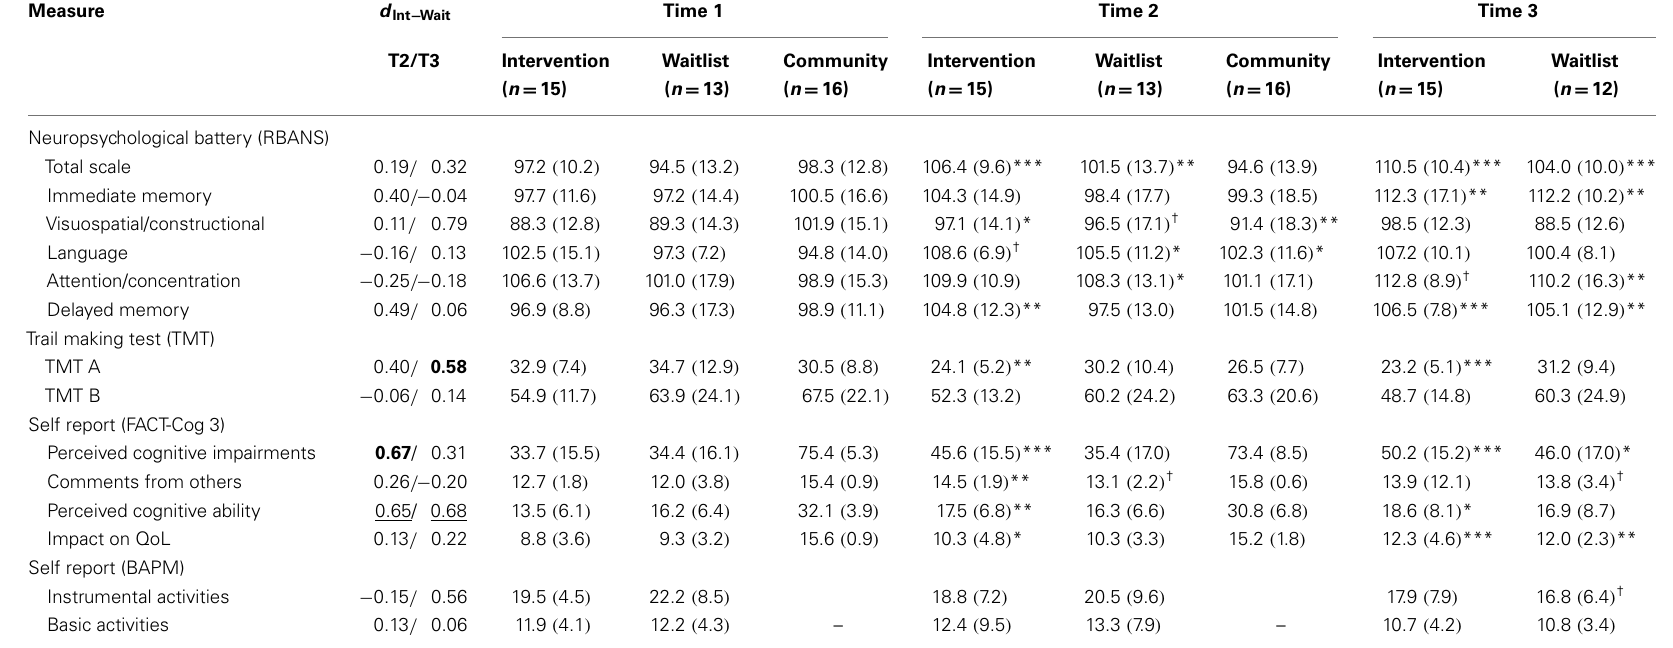
Table 3 | Effect sizes, means (and standard deviations) for cognitive measures .